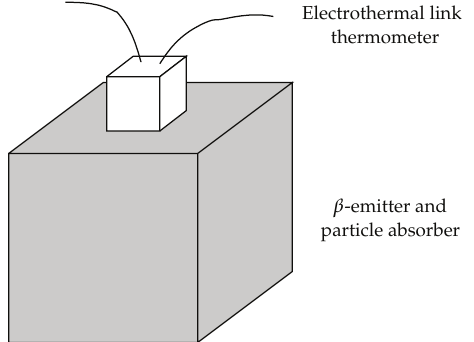
Figure 13: Principle scheme of a cryobolometer for direct neutrino mass measurements consisting of a 𝛽 -emitting crystal, which serves at the same time as the particle and energy absorber. The electric read-out wires of the thermometer link the whole bolometer to a thermal